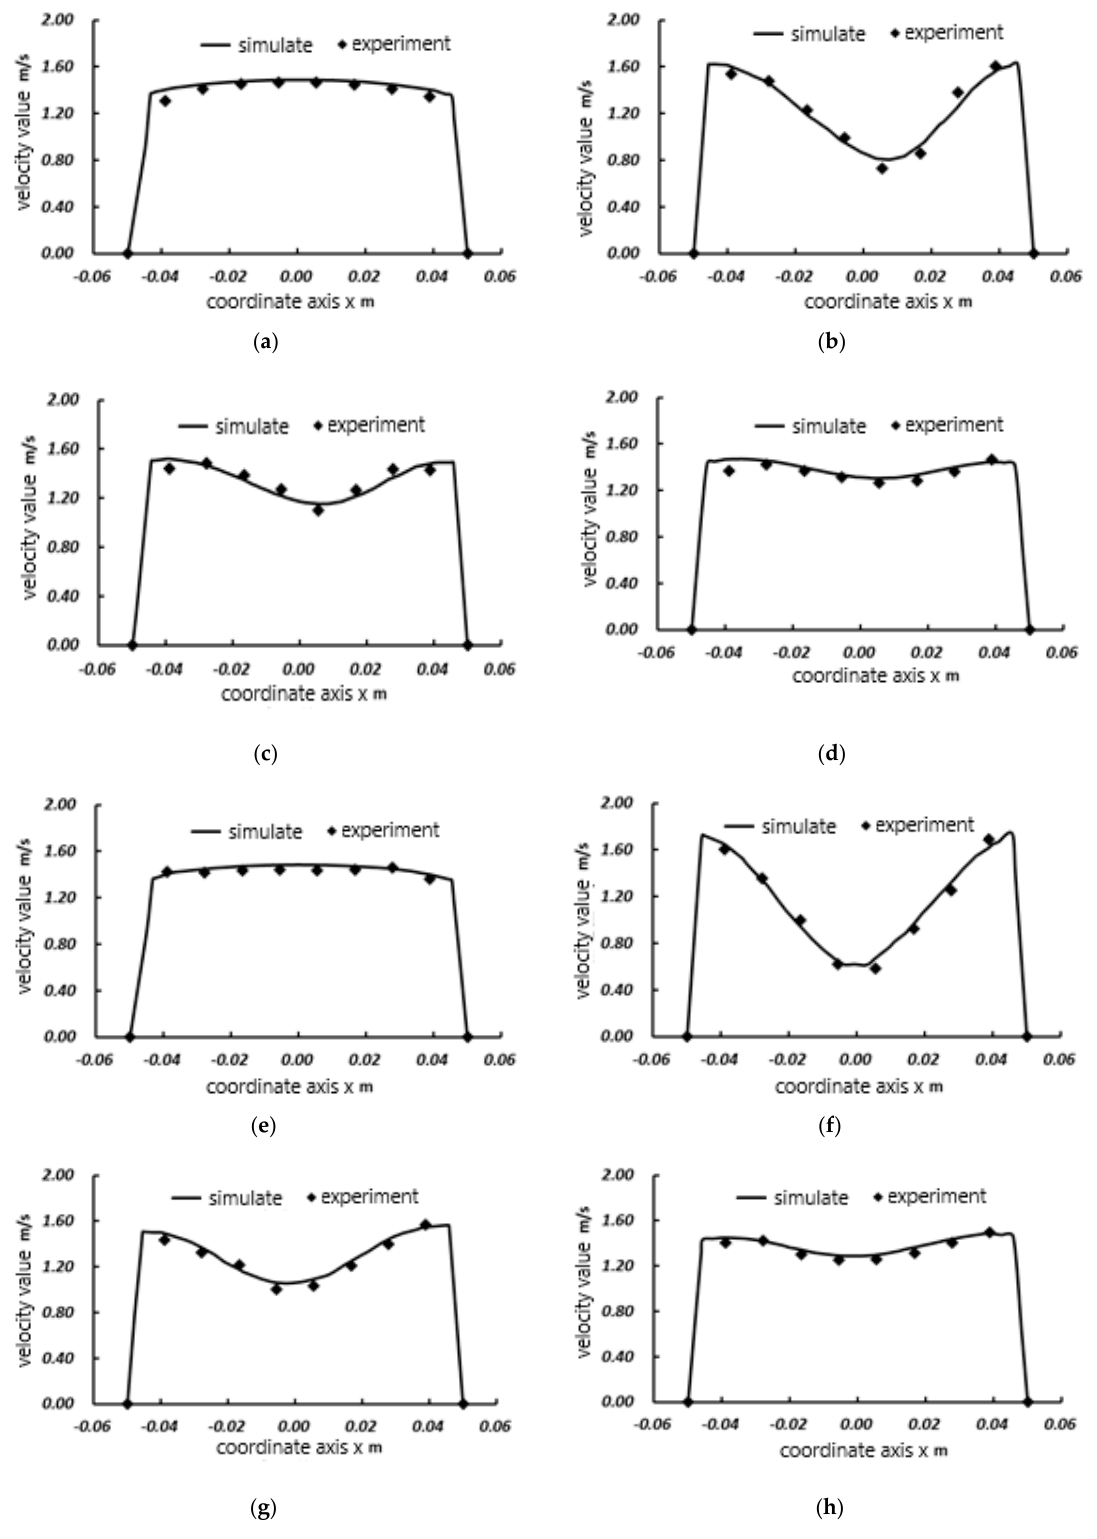
Figure 5. Experimental and simulation results of axial flow velocity during the process of transporting material in the capsule: ( a ) length–diameter ratio ( L / D ) = 2, the upstream section of the capsule Z u = 0.15 m; ( b ) L / D = 2, the downstream section of the capsule Z d = 0.15 m; ( c ) L / D = 2, Z d = 0.30 m; ( d ) L / D = 2, Z d = 0.45 m; ( e ) L / D = 1.67, Z u = 0.15 m; ( f ) L / D = 1.67, Z d = 0.15 m; ( g ) L / D = 1.67, Z d = 0.30 m; ( h ) L / D = 1.67, Z d = 0.45 m.